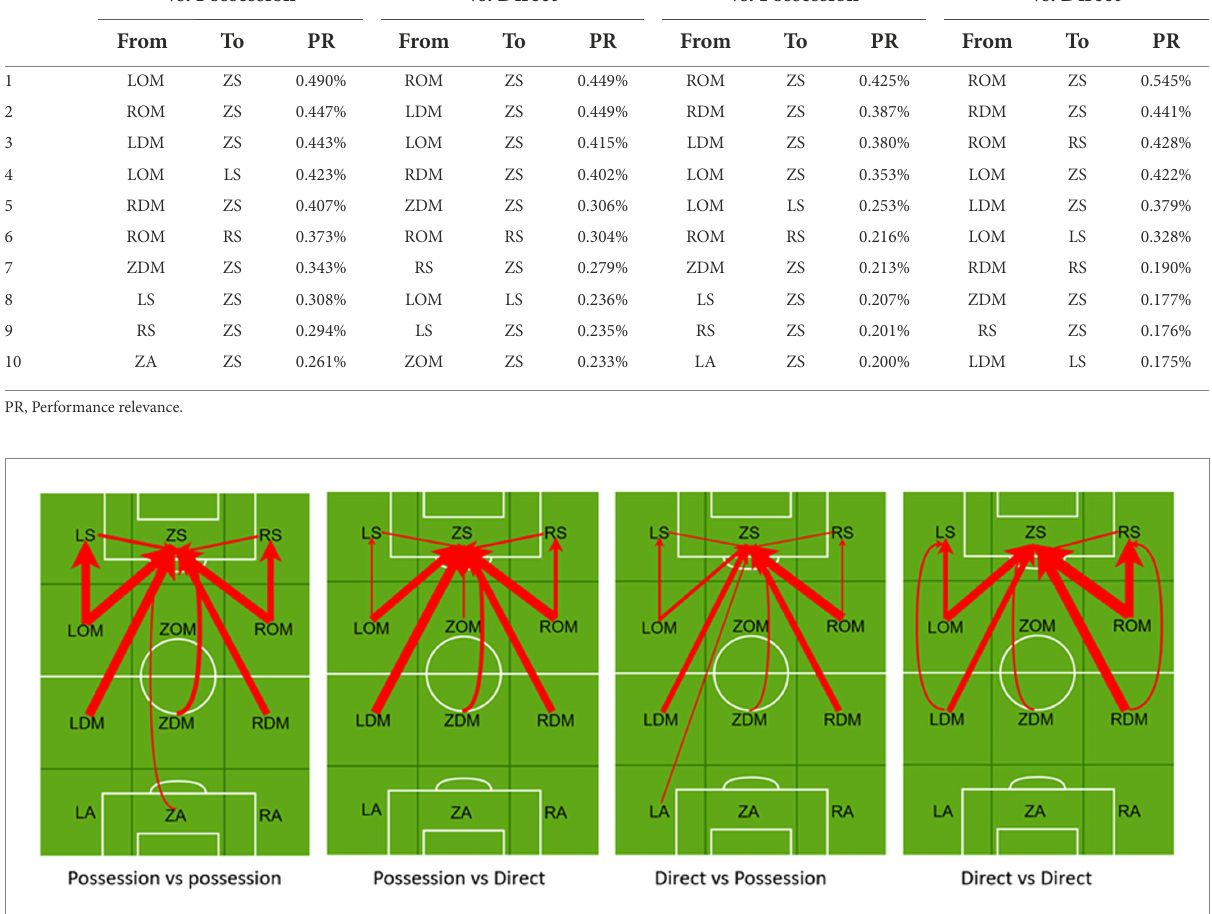
FIGURE 4 Diagnostical analysis of passing routines among top three teams in the World Cup